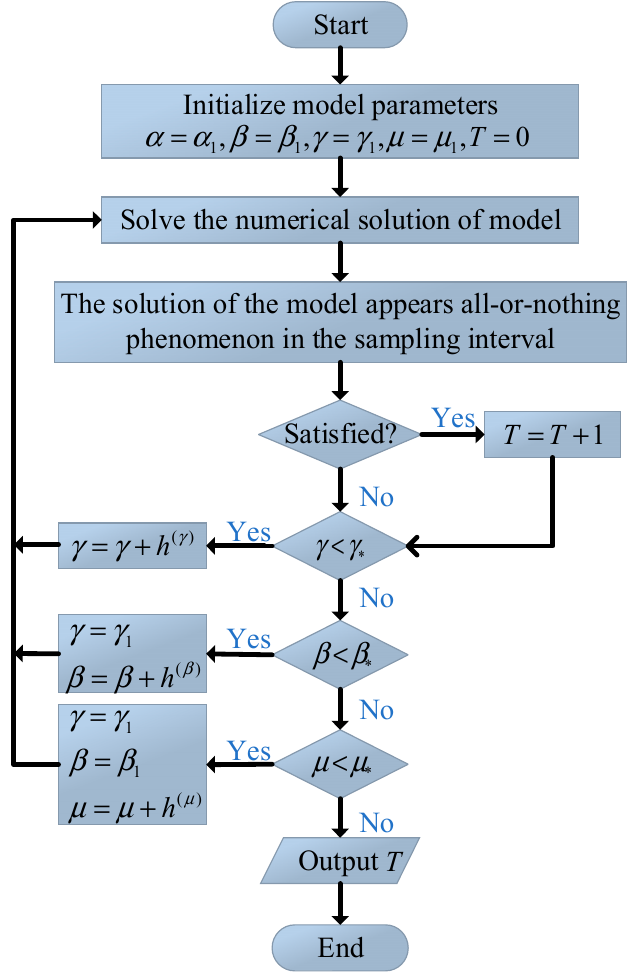
Figure 8. Flowchart of obtaining the value of T . Table 2. The initial values of the model